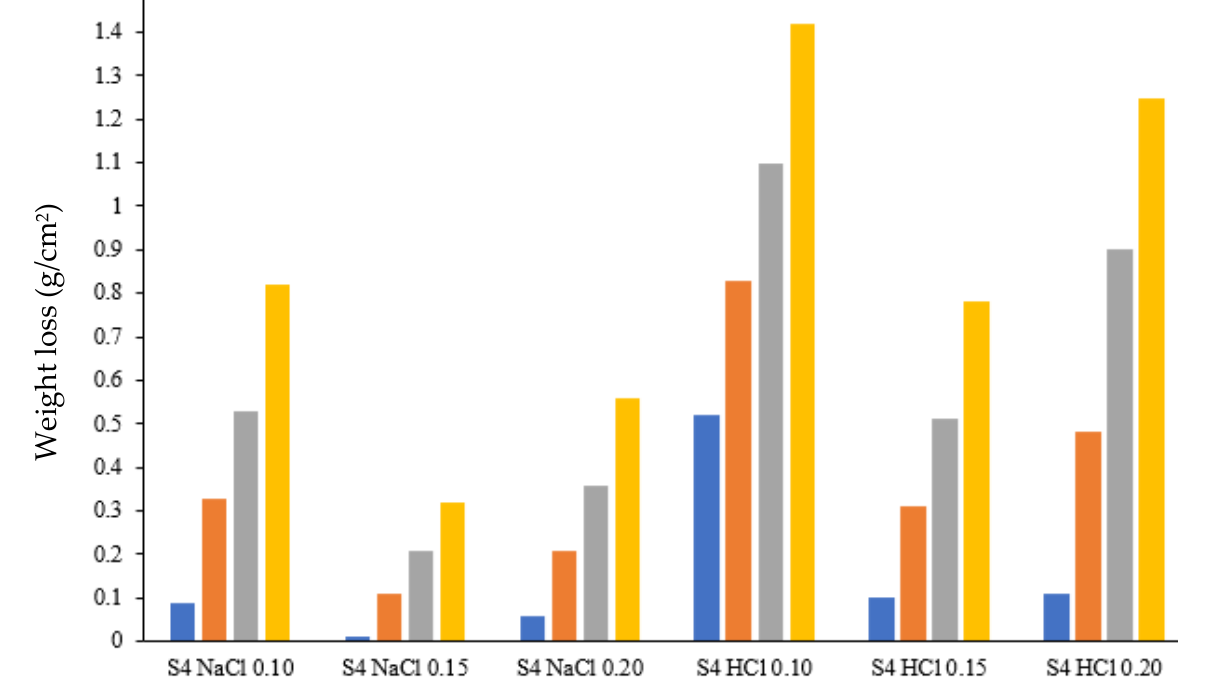
Figure 10. Effect of heat treatment on corrosion behaviour of S T4 (2%).